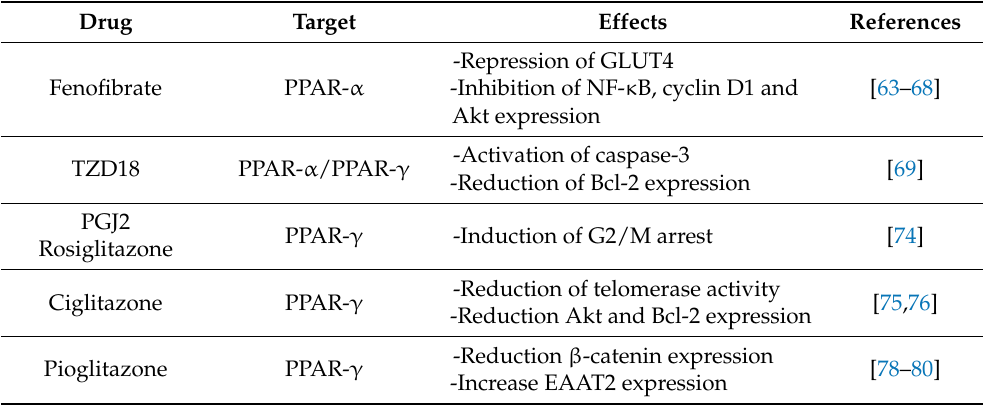
Table 1. This table summarizes the studies that analyze the effects of PPAR